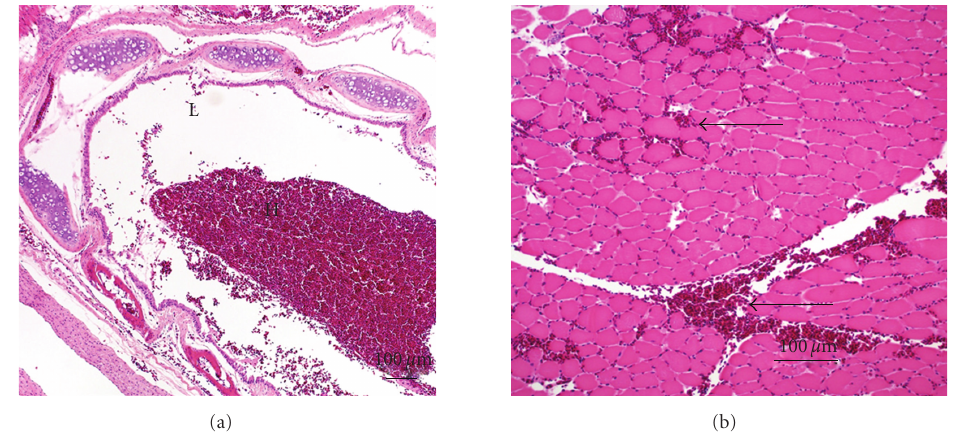
Figure 3: Toxicity of Nandina domestica in Cedar Waxwings. (a). Photomicrograph showing hemorrhage (H) in the tracheal lumen (L). H&E stain. Bar: 100 μ m. (b). Photomicrograph showing multifocal hemorrhage in skeletal muscle (arrows). H&E stain. Bar: 100 μ